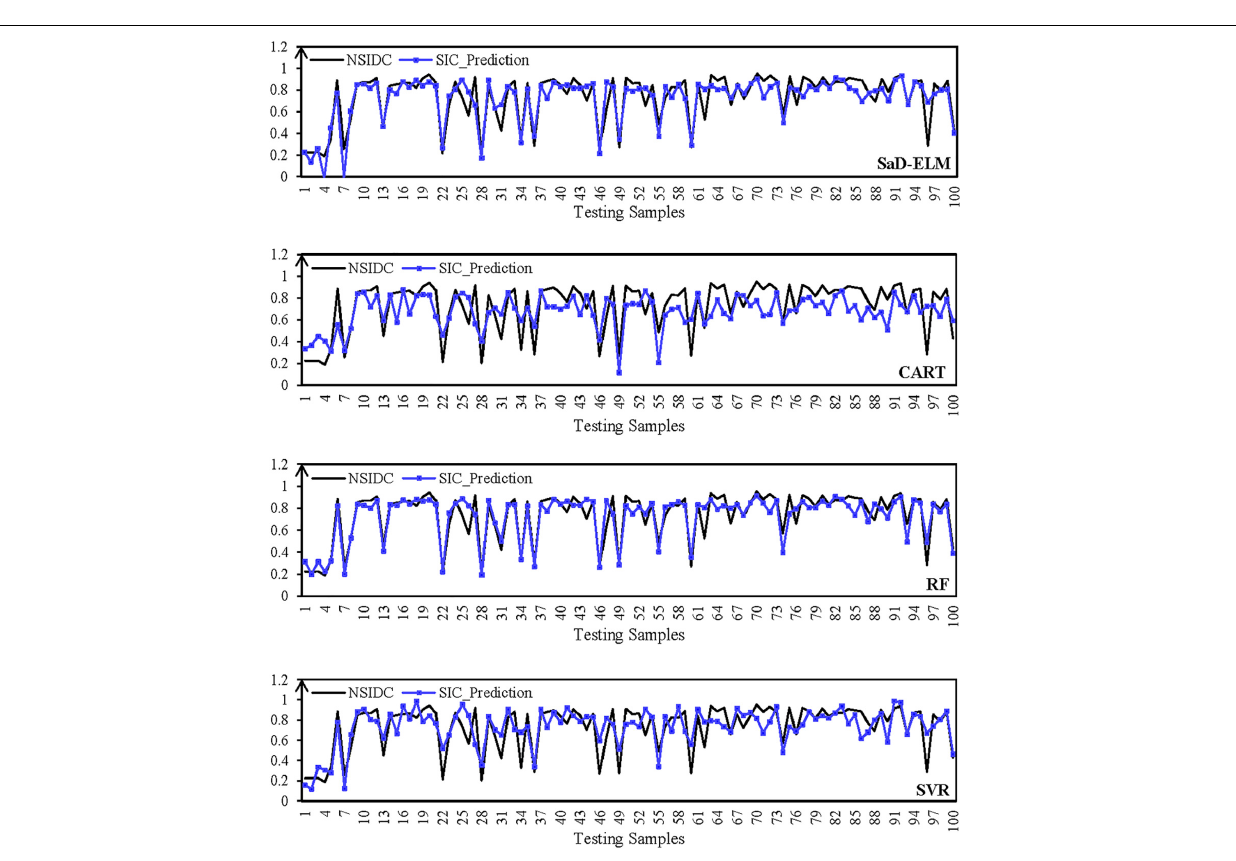
Frontiers in Marine Science |